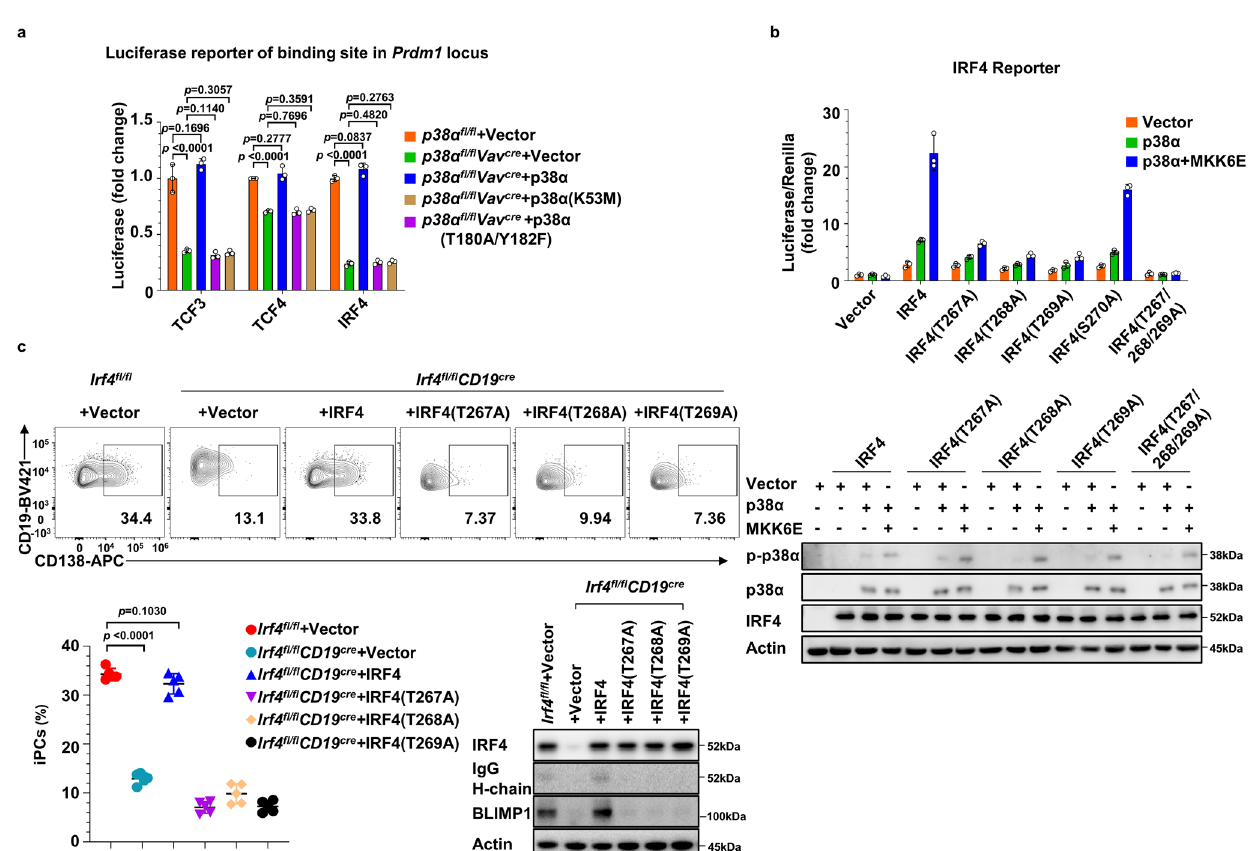
c Cultured Irf4 − / − B cells were transduced with retroviruses encoding IRF4 or IRF4 mutants (T267A, T268A, T269A) at day 2, iPCs in retrovirally transduced B cells (CD19 + GFP + CD138 + ) 6 days after transduction were analyzed by fl ow cytometry ( n =5 per group), and protein levels of IRF4, IgG H-chain, BLIMP1 and Actin were analyzed by immunoblot. Data were representative of at least three independent experiments. Each symbol represents a representative sample. Small horizontal lines indicate the mean (±s.d.). Data were analyzed by two-tailed unpaired t-tests. Source data are provided as a Source Data fi